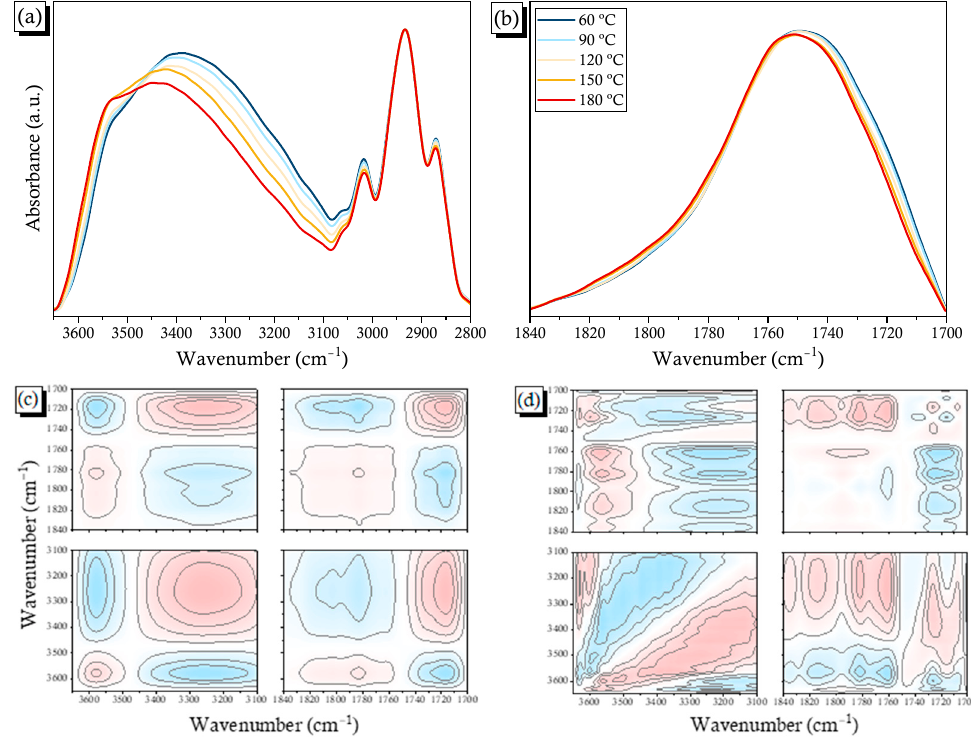
Figure 6. ( a , b ) FTIR spectra of the PCHC-50 binary blend, recorded at various temperatures: ( a ) OH and ( b ) C=O regions; ( c , d ) Corresponding 2D FTIR spectral; ( c ) synchronous; and ( d ) asynchronous correlation maps.